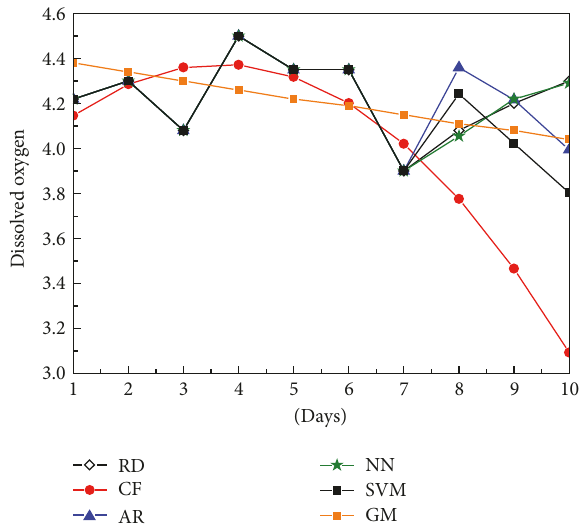
Figure 5: The actual value and predicted value for the third pond.